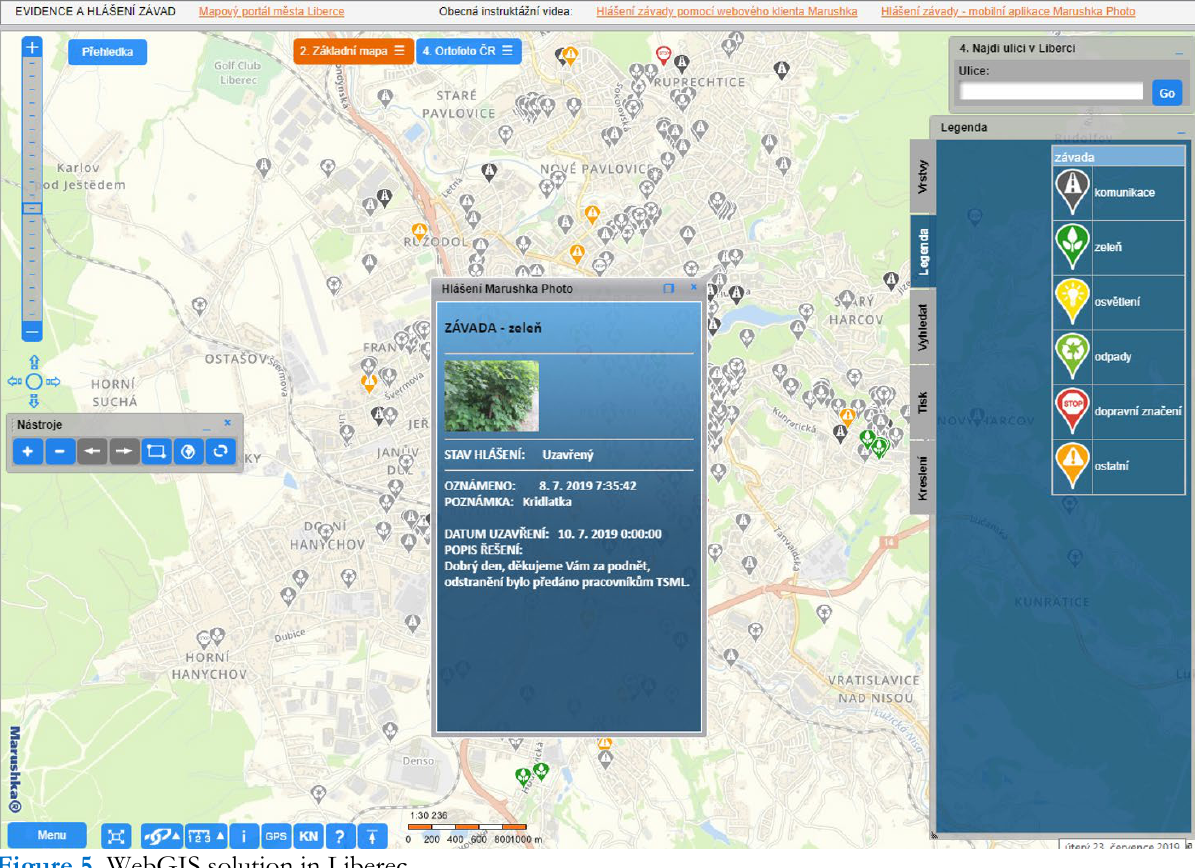
Figure 5. WebGIS solution in